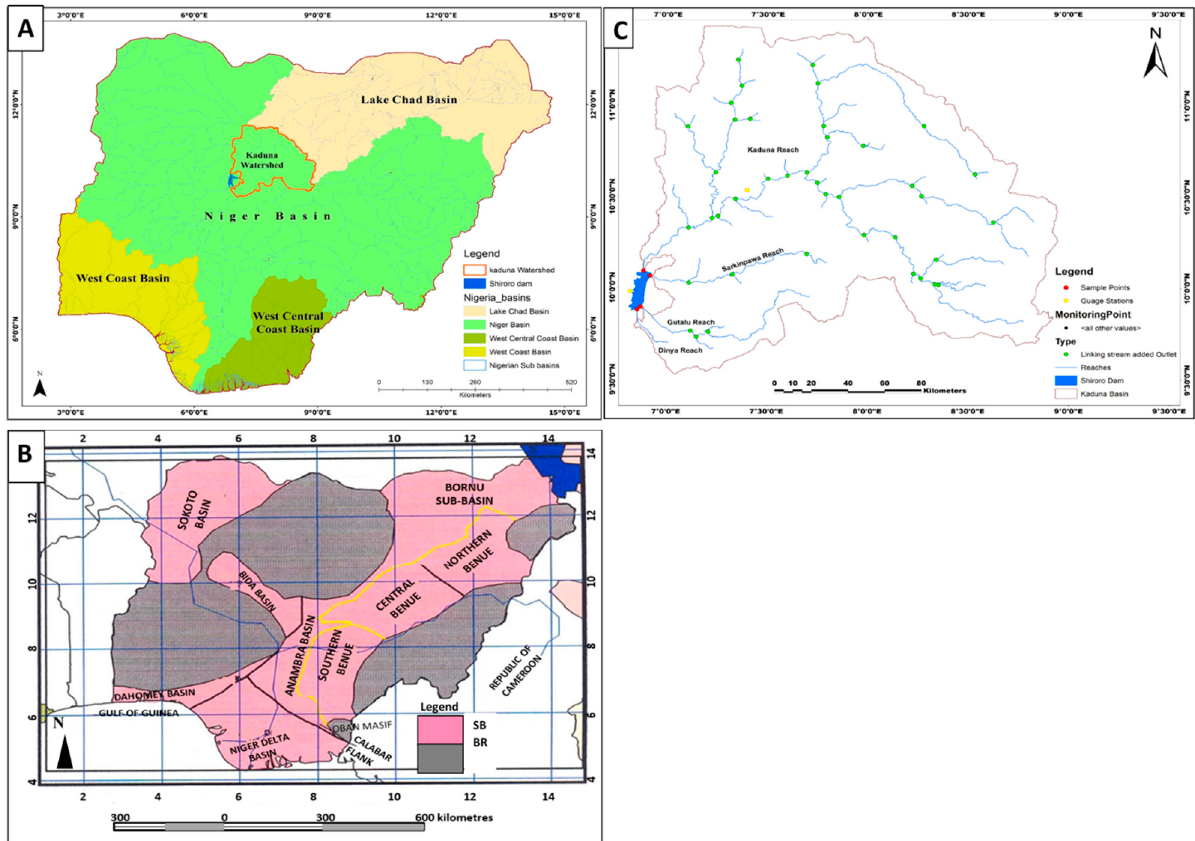
Figure 1. Study location: ( A ) Annotated map of Nigeria showing the Kaduna watershed and other basins, ( B ) Geological map of Nigeria showing areas overlaid by sedimentary basins (SB) and basement rocks (BR)- Adapted from Ola and Adepehin 2017 [6], ( C ) Map of the Kaduna Watershed showing the Shiroro Dam, major tributaries, delineated reaches, sampling points, and gauge stations.